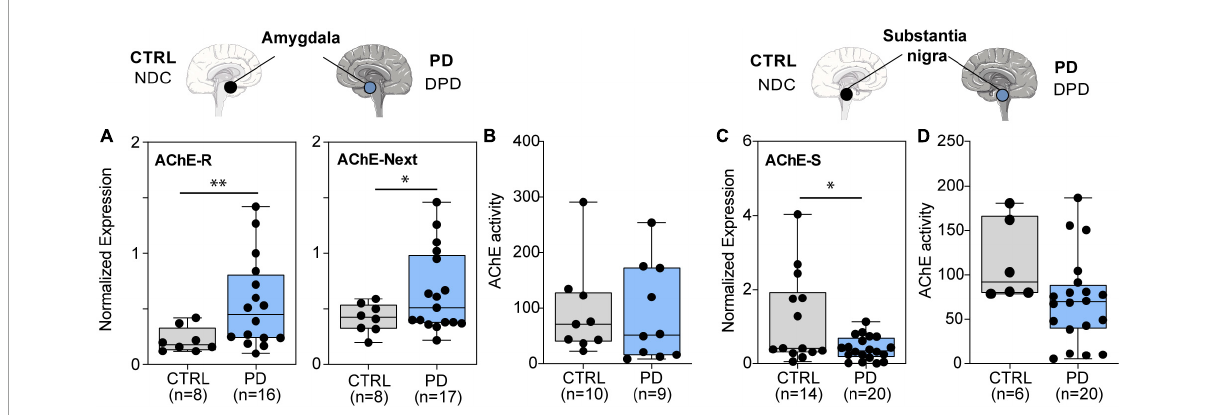
FIGURE4 PD-modified levels of brain cholinesterase transcripts and AChE enzyme activity in the amygdala and substantia nigra. (A) Elevated mRNA levels of AChE-R ( p < 0.023) and AChE-Next ( p < 0.05) variants. (B) Unchanged AChE enzyme activity in PD compared with controls in the amygdala. (C) Decreased AChE-S mRNA levels ( p < 0.05). (D) Decreased AChE enzyme activity ( p = 0.078) in PD compared to controls in the substantia nigra. Normalized expression represents (cid:49)(cid:49) Cq, and enzyme activity is in nmol ATCh/min/mg protein, ∗ p < 0.05, ∗∗ p <